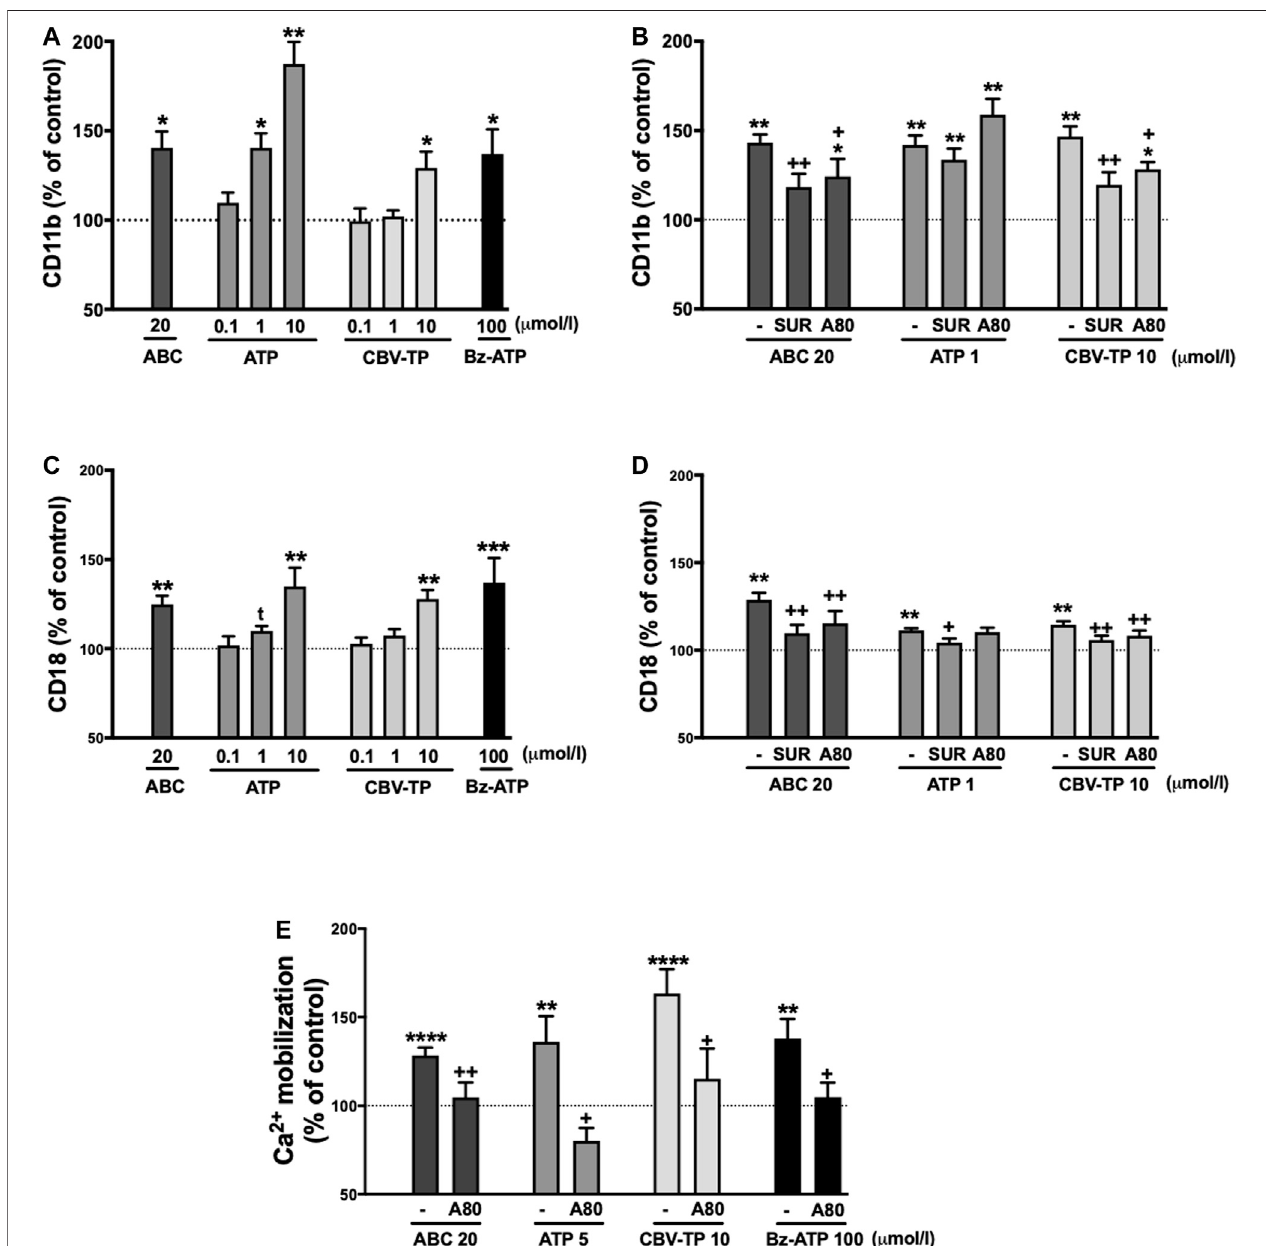
FIGURE 3 | Mac-1 expression and calcium in fl ux in neutrophils. Whole blood (4 h) for Mac-1 expression or PMN (1 h) for calcium in fl ux were treated with ABC (20 µmol/L), ATP (0.1 – 10 µmol/L) or CBV-TP (0.1 – 10 µmol/L), and the surface expression on neutrophils of the two subunits of Mac-1 CD11b (A, B) and CD18 (C, D) , and calcium mobilization (E) were quanti fi ed. In some cases, blood or PMN were pretreated with suramin (Sur, nonselective P2R antagonist, 100 μ mol/L, 60 min) or A804598 (A80, P2X7R antagonist, 1 μ mol/L, 30 min) prior to treatment with ABC (20 µmol/L), ATP (1 µmol/L), ATP (5 µmol/L), CBV-TP (10 µmol/L) or Bz-ATP (100 µmol/L). Fluorescence values are expressed as percentage of mean of median fl uorescence intensities of control cells (dotted line). Results are mean ± SEM, Veh: n ≥ 11, ABC 20: n ≥ 15, ATP 0.1: n ≥ 6, ATP 1: n ≥ 6, ATP 5: n (cid:2) 10, ATP 10: n ≥ 7, CBV-TP 0.1: n ≥ 6, CBV-TP 1: n ≥ 10, CBV-TP 10: n ≥ 5, Bz-ATP 100: n ≥ 6, ABC 20+Sur: n ≥ 9,ABC20+A80: n ≥ 5,ATP1+Sur: n ≥ 10,ATP1+A80: n ≥ 11,ATP5+A80: n ≥ 4,CBV-TP10+Sur: n ≥ 12,CBV-TP10+A80: n ≥ 4,Bz-ATP100+A80: n ≥ 4, * p < 0.05, ** p < 0.01 or **** p < 0.0001vs. correspondingvalue in vehicle-treated group.+ p < 0.05 or ++ p < 0.01 vs. corresponding valuein ABC,ATPor CBV-TP- treated group (ANOVA followed by Newman-Keuls test), t p < 0.05 vs. corresponding value in vehicle-treated group ( t -test).